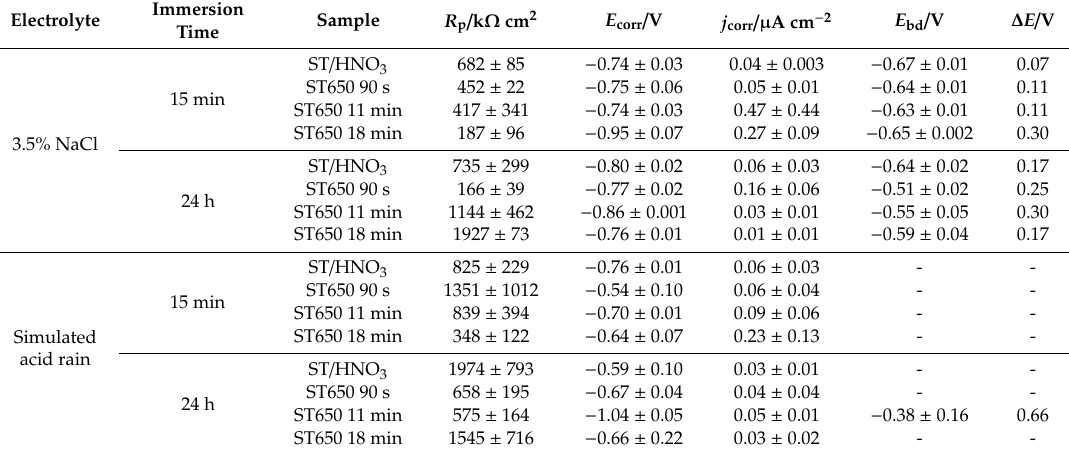
Table 6. The polarization resistance ( R p ), corrosion potential ( E corr ), corrosion current density ( j corr ), breakdown potential ( E bd ) and the extent of the passive range ∆ E = | E bd − E corr | measured in 3.5% NaCl and simulated acid rain after 15 min and 24 h immersion for chemically pre-treated